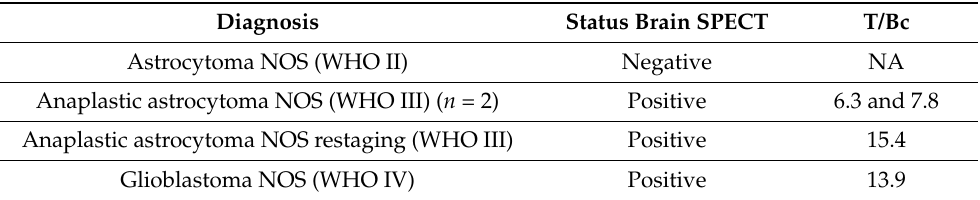
Table 2. Tumor-to-contralateral tissue background ratio (T/Bc) of [ 99m Tc]Tc-iFAP in patients with high-grade WHO III–IV